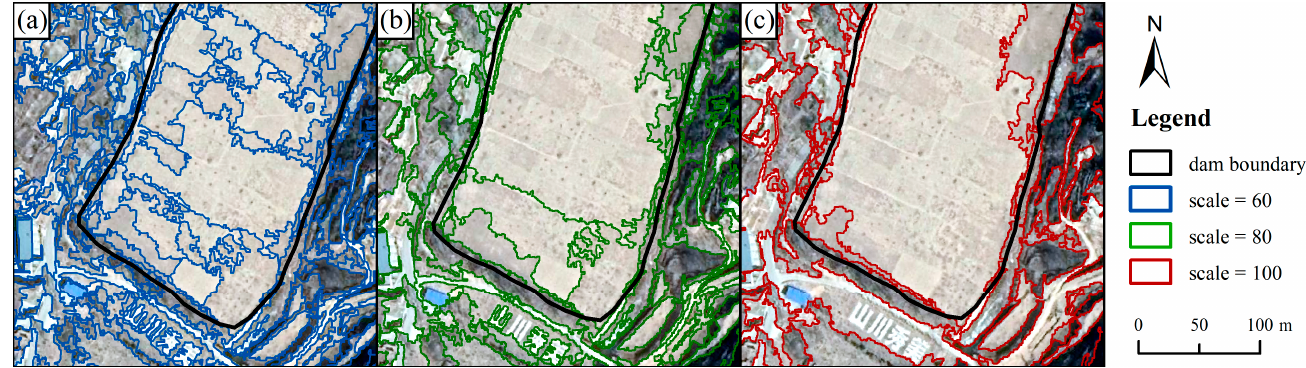
Figure 6. Multi-resolution segmentation results with different scale parameters. ( a ) scale = 60; ( b ) scale = 80; ( c ) scale = 100 (their shape and compactness parameters are all 0.1 and 0.5, respectively).